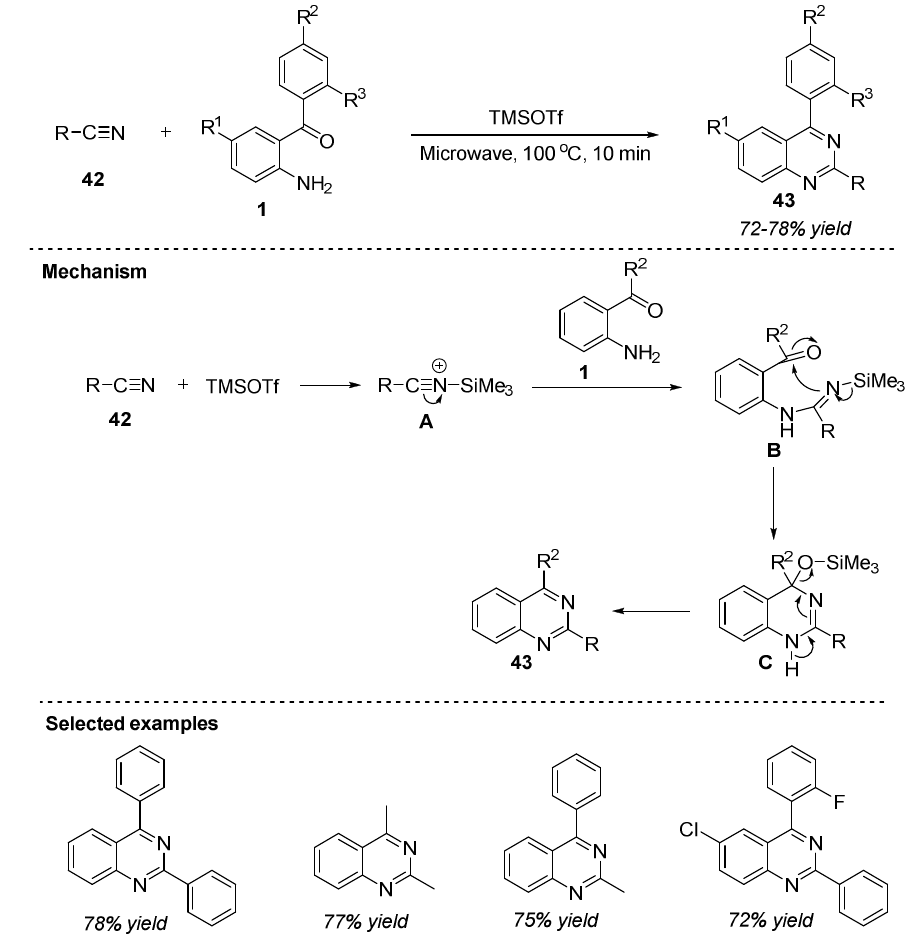
Scheme 20. TMSOTf-catalyzed reaction for the synthesis of